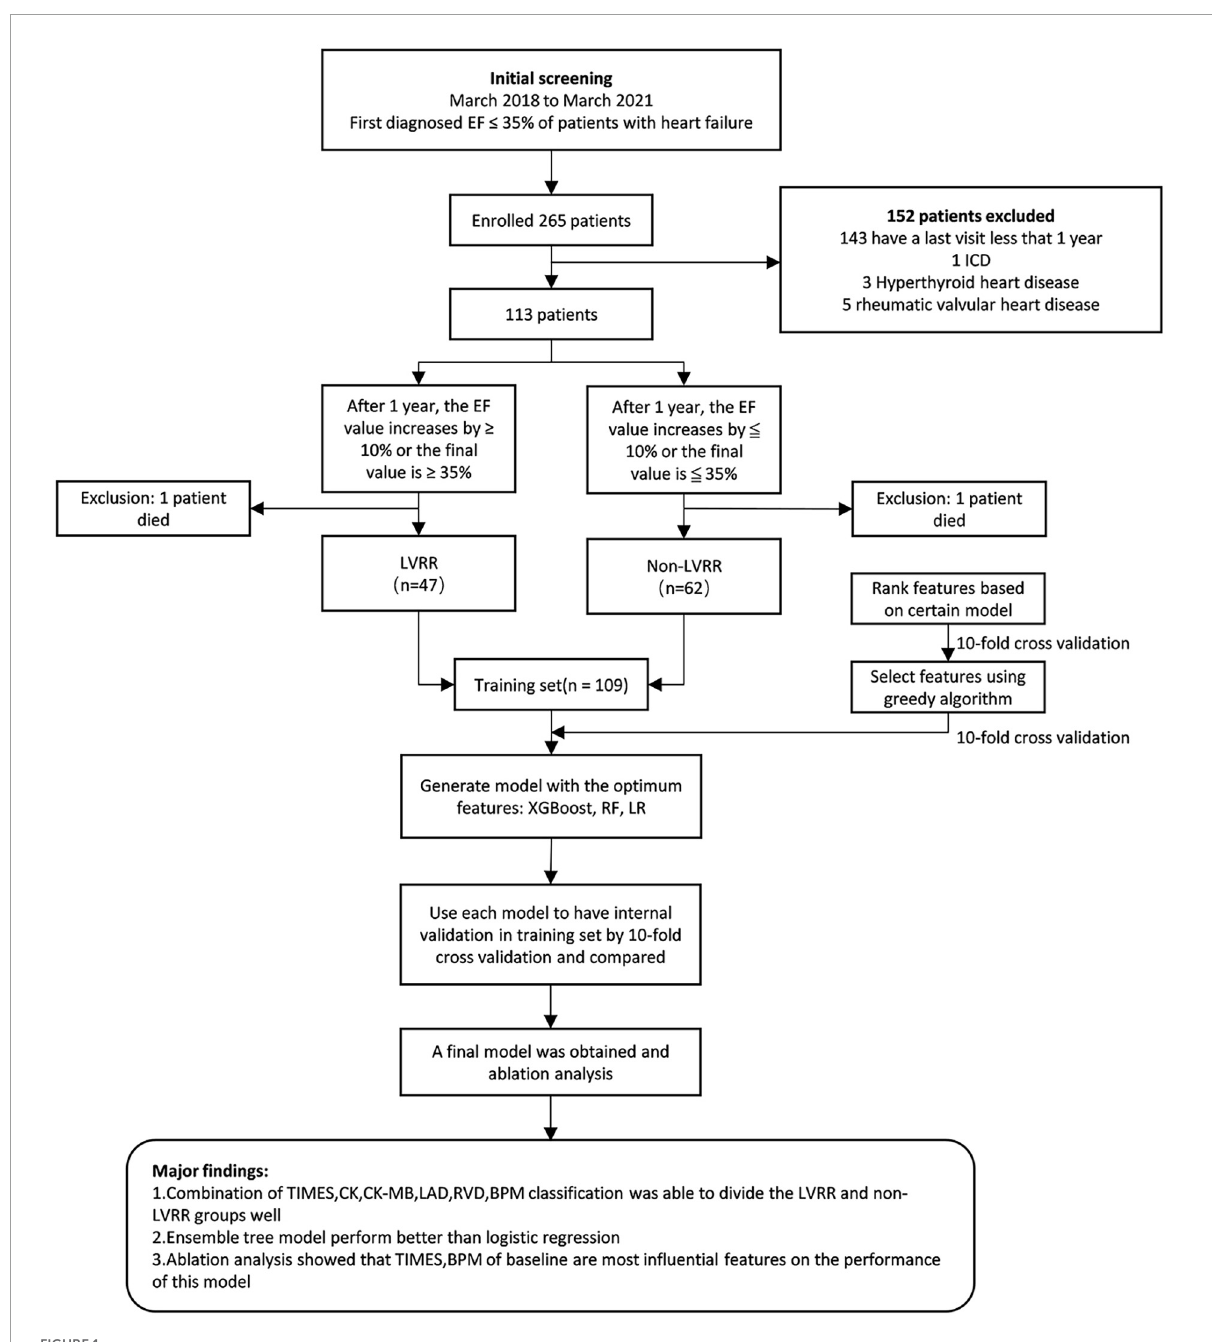
FIGURE1 Major results of the research and overall flowchart. EF, left ventricular ejection fraction; LVRR, left ventricular reverse remodeling; XGBOOST, extreme gradient boosting; LR, logistic regression; RF, random